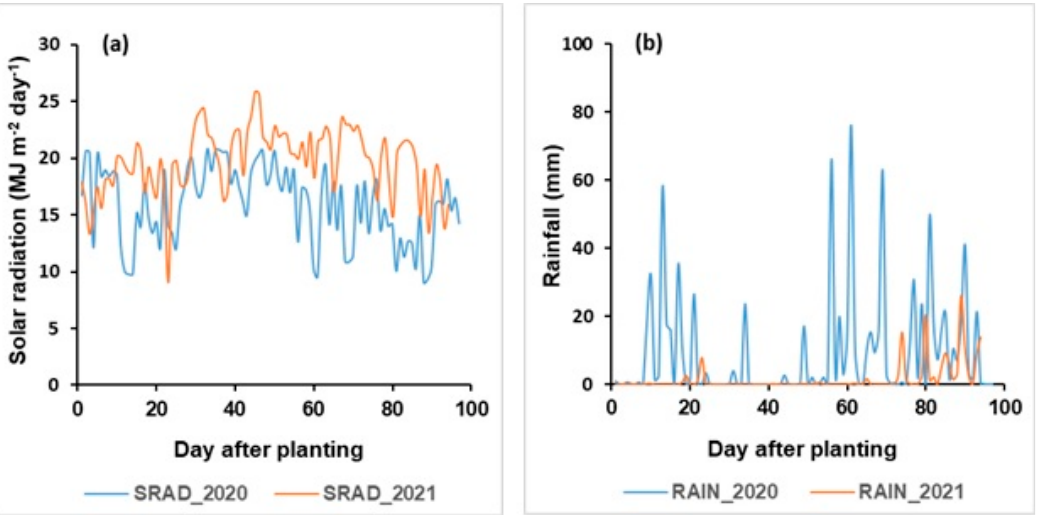
Figure 4. Daily solar radiation ( a ) and rainfall ( b ) for Summer–Autumn season 2020 and Spring– Winter season 2021.